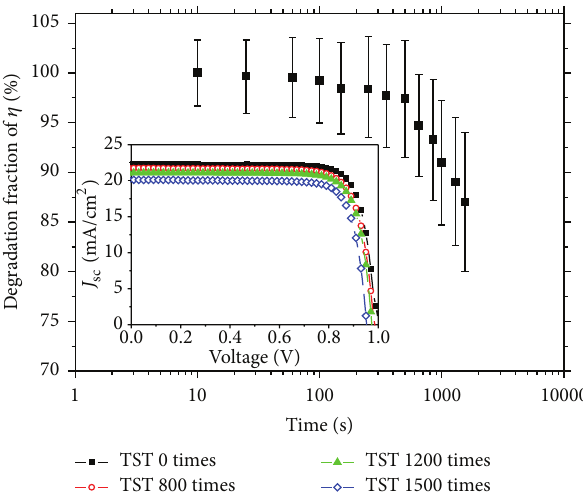
Figure 6: The degradation faction of conversion efficiency for GaAs thin-film solar cell transferred to electroplated Ni substrate after thermal shock test (cycle time are 0, 800, 1200, and 1500 times). The insert is the I-V curve of thin-films GaAs solar cell with different thermal shock test times.